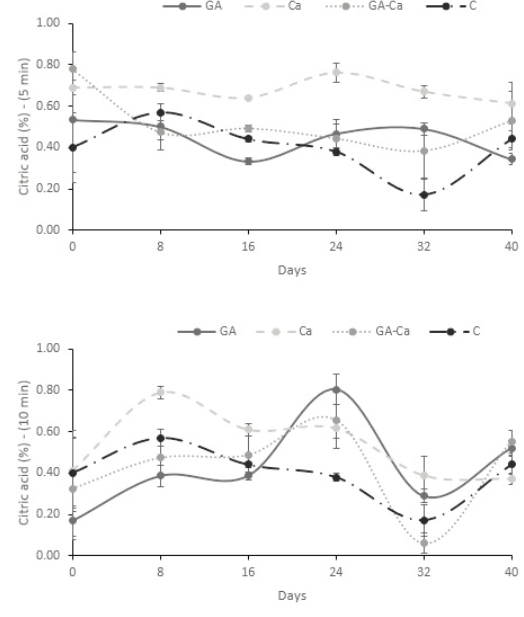
Fig. 2 ­ Effects of the treatments applied using both dipping times (5 and 10 min) on the citric acid content during cold storage. Treatments: GA, Ca, mix GA­Ca, C (Control­ no use of GA and Ca). Values are the mean three replica­ tes, and vertical bars represent ±